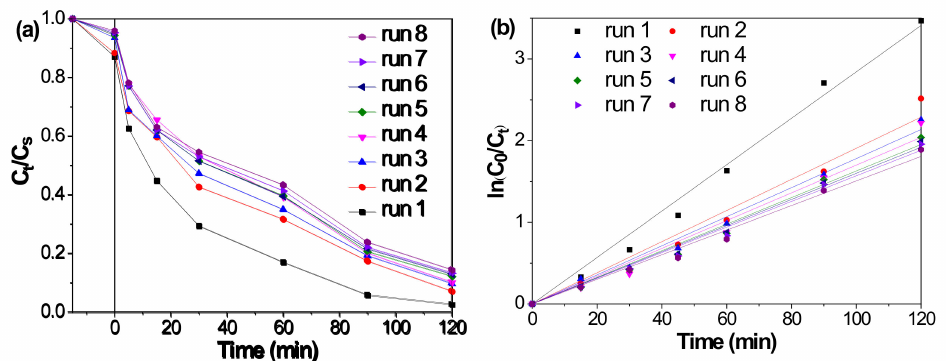
Figure 4. Recyclability tests of F-Fe 3 O 4 -1 for catalytic degradation of OG with H 2 O 2 . ( a ) C t /C s -time plots and ( b ) ln(C 0 /C t )-time plots. Reaction conditions: fresh F-Fe 3 O 4 -1: 0.5 g/L, OG (0.1 mM, pH 6.5), and H 2 O 2 : 40 mM at 40 ◦ C for 2 h. The used F-Fe 3 O 4 -1 was magnetically recovered and directly re-used as the